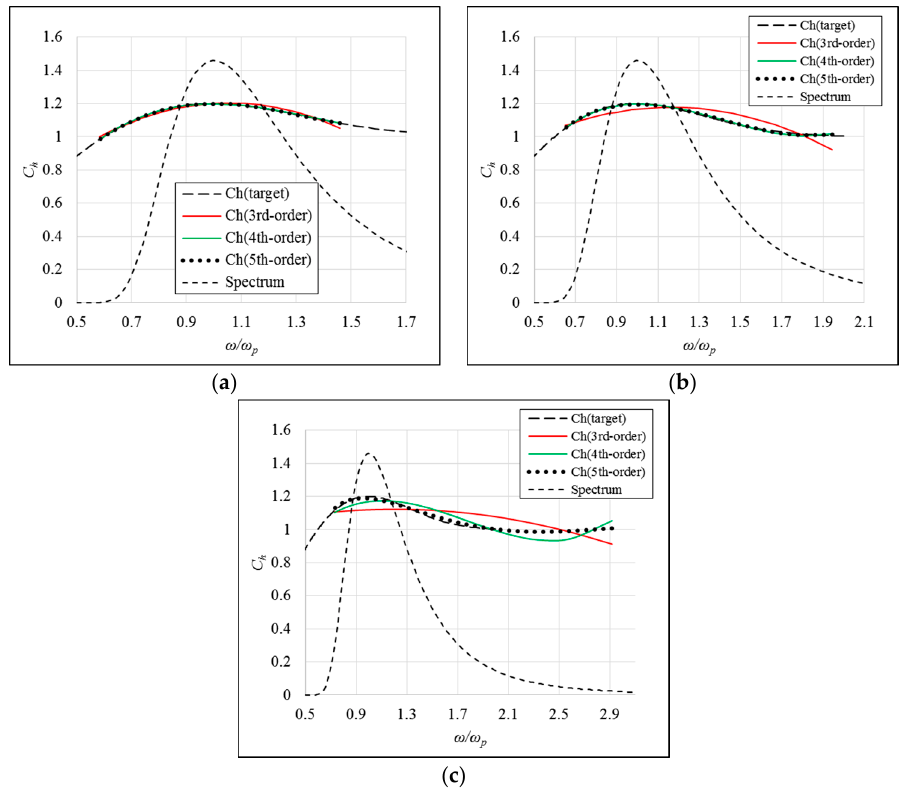
Figure 4. C h approximations for different frequency ranges (note: T e = 2 π / ω e is the wave energy period). ( a ) 0.5 ω e –1.25 ω e ; ( b ) 0.5 ω e –1.67 ω e ; ( c ) 0.5 ω e –2.5 ω e .